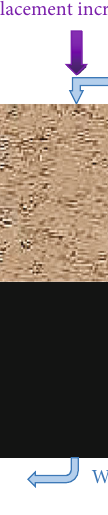
Figure 2: Method of applying external load. Table 1: Main parameters of numerical model.